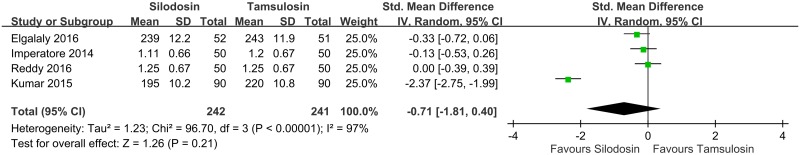
Forest plot of requirement for analgesics.